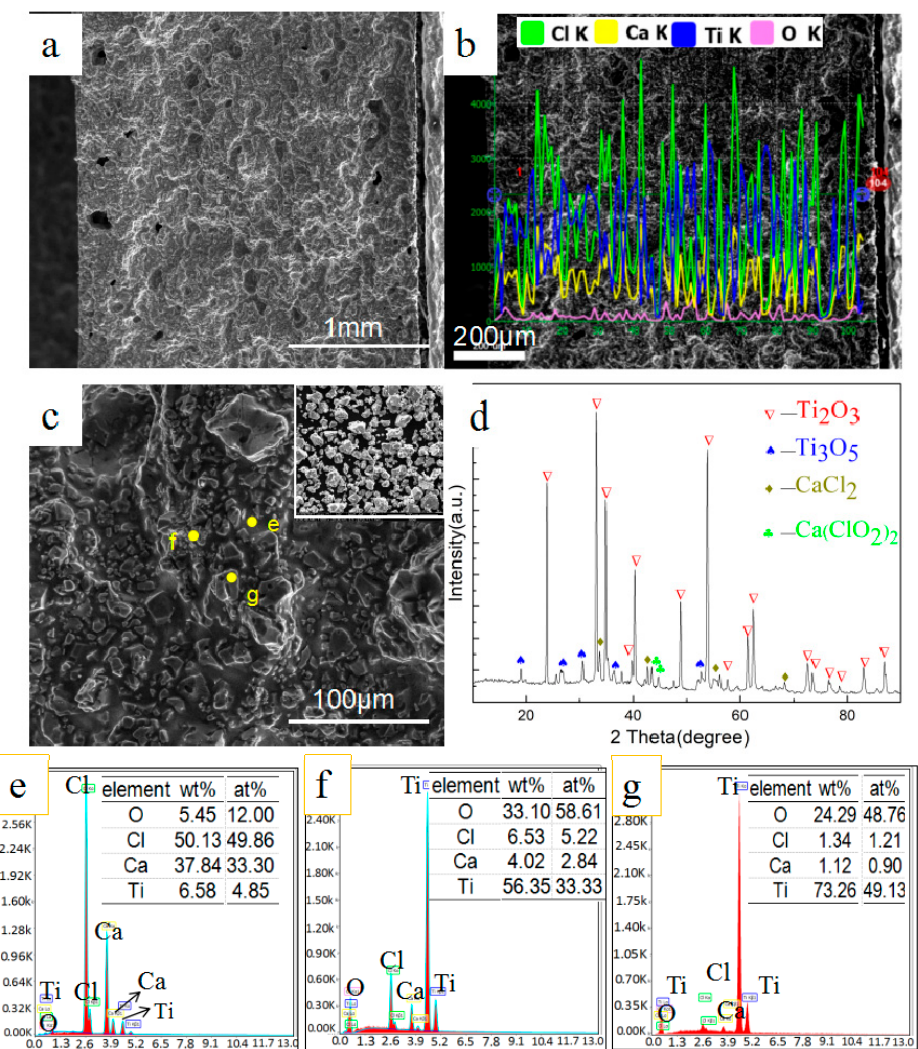
Figure 2. Scanning electron microscopy with energy dispersive spectroscopy (SEM ‐ EDS) and X ‐ ray diffraction (XRD) analysis of cross section of sintered sample at 1125 K: ( a ) overall morphology; ( b ) line ‐ scan image; ( c ) local morphology; ( d ) XRD pattern; ( e – g ) EDS results of ( c ).